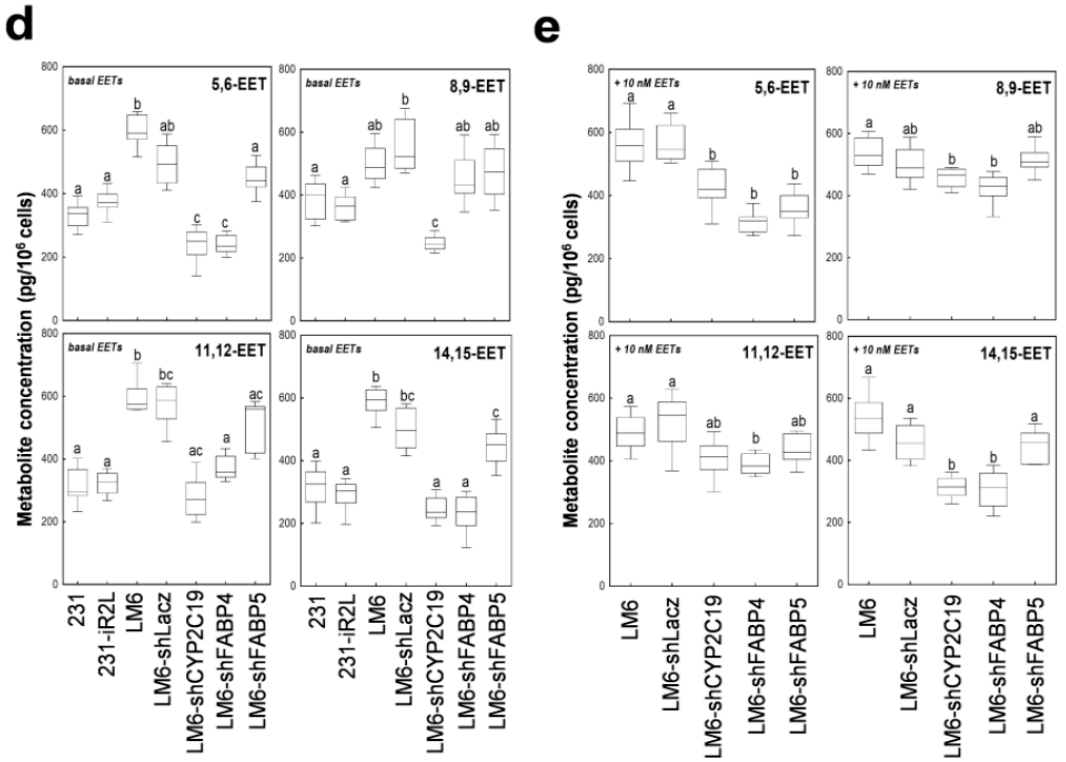
Figure 2. Lung-seeking and highly metastatic MDA-MB-231 TNBC cells are characterized by increased FABP4 and FABP5 gene and protein expressions and elevated EET levels. ( a ) Gene expression of FABP4 and FABP4 are significantly upregulated in LM6 cells as compared with immortalized mammary epithelial cells (MCF10A), parental 231, or 231-iR2L, and earlier metastatic subclones LM2 and LM4; ( b ) immunoblot analysis shows increased expression of FABP4, FABP5, and CYP2C19, as well as metastasis, EMT, and stromal interaction-related markers in acclimated lung-seeking subclone of MDA-MB-231 cells (LM6), which were decreased in the specific gene knockdown cell clones, LM6-shFABP4, LM6-shFABP5, and LM6-shCYP2C19; ( c ) representative blots from three independent experiments are shown. shRNA clones with asterisks were used in subsequent experiments; ( d ) box plots show the basal intracellular concentration of AA-derived EET isomers (5,6-EET, 8,9-EET, 11,12-EET, and 14,15-EET) in the parental MBA-MB-231 and 231-iR2L TNBC cells, its lung-seeking LM6 subclone, and in FABP4, FABP5, or CYP2C19-depleted LM6 cells analyzed using UPLC-MS / MS spectrometry; and ( e ) corresponding intracellular EET levels of each the cell lines under study were compared following 24 h culture in media supplemented with 10 nM of a specific EET isomer. All analyses include 3 biological replicates and 4 technical replicates. Error bars indicate mean ± SEM. Statistical significance of the data between different groups are denoted by different letters or asterisks, when applicable ( p = 0.05, ANOVA, post hoc Tukey).